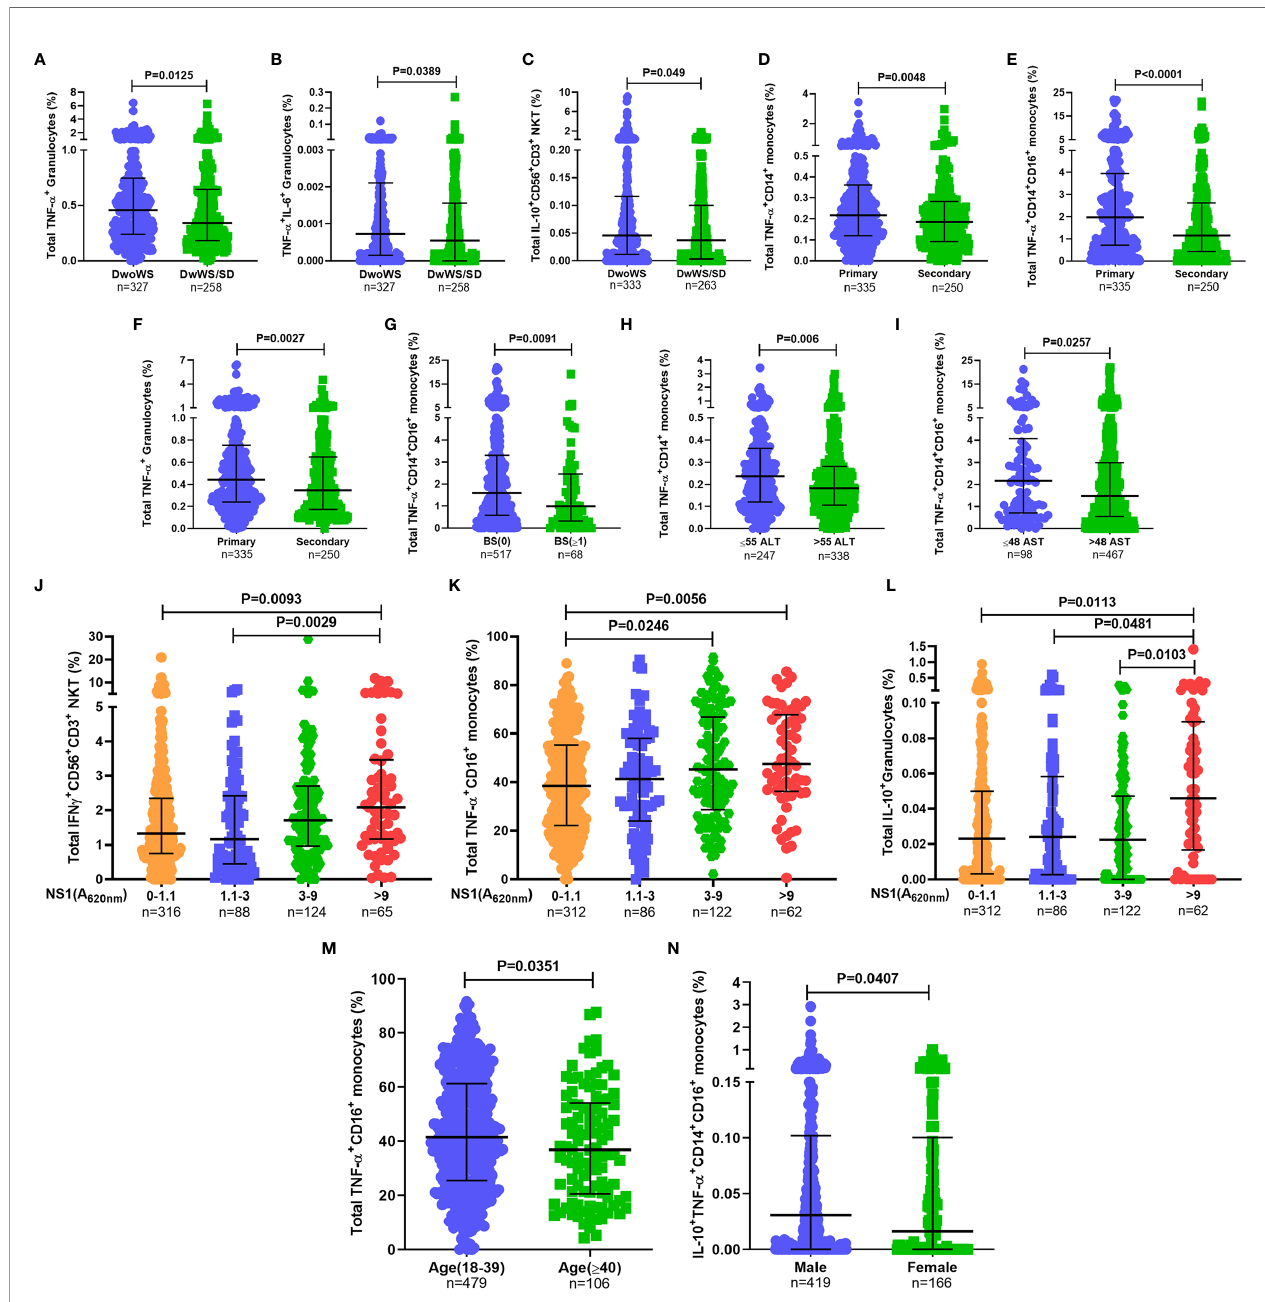
FIGURE 5 | Higher percentages of innate immune cells secreting in fl ammatory cytokines were associated with better prognosis. Frequency of (A) total TNF- a + granulocytes, (B) TNF- a + IL-6 + granulocytes, and (C) total IL-10 + CD56 + CD3 + NKT cells compared between DwoWS (circle) and DwWS/SD (square). Frequency of total (D) TNF- a + CD14 + monocytes, (E) TNF- a + CD14 + CD16 + intermediate monocytes and (F) TNF- a + granulocytes compared between primary (circle) and secondary patients (square). (G) Frequency of total TNF- a + CD14 + CD16 + monocytes compared between bleed-scores 0 [BS(0); circle] and bleed-scores ≥ 1 (BS ≥ 1; square). Frequency of total (H) TNF- a + CD14 + monocytes and (I) TNF- a + CD14 + CD16 + monocytes compared between normal (circle) and elevated (square) ALT (>55 IU/L; E ) and AST (>48 IU/L; F ), respectively. Frequency of total (J) IFN- g + CD56 + CD3 + NKT cells, (K) TNF- a + CD16 + non-classical monocytes and (L) IL-10 + granulocytes compared between patients with undetectable NS1 (A620 nm 0 – 1.1), low NS1 (A620 nm 1.1 to 3), intermediate NS1 (A620 nm 3 to 9), and high NS1 (A620 nm> 9) values. (M) Frequency of total TNF- a + CD16 + non-classical monocytes in young (18 – 39 years; circle) compared to old ( ≥ 40 years; square) patients. (N) Frequency of IL-10 + TNF- a + CD14 + CD16 + intermediate monocytes in men (circle) compared to women (square). P-values were determined using Mann – Whitney U test and Kruskal – Wallis test, followed by Bonferroni correction for multiple comparisons between groups. Median with IQR is